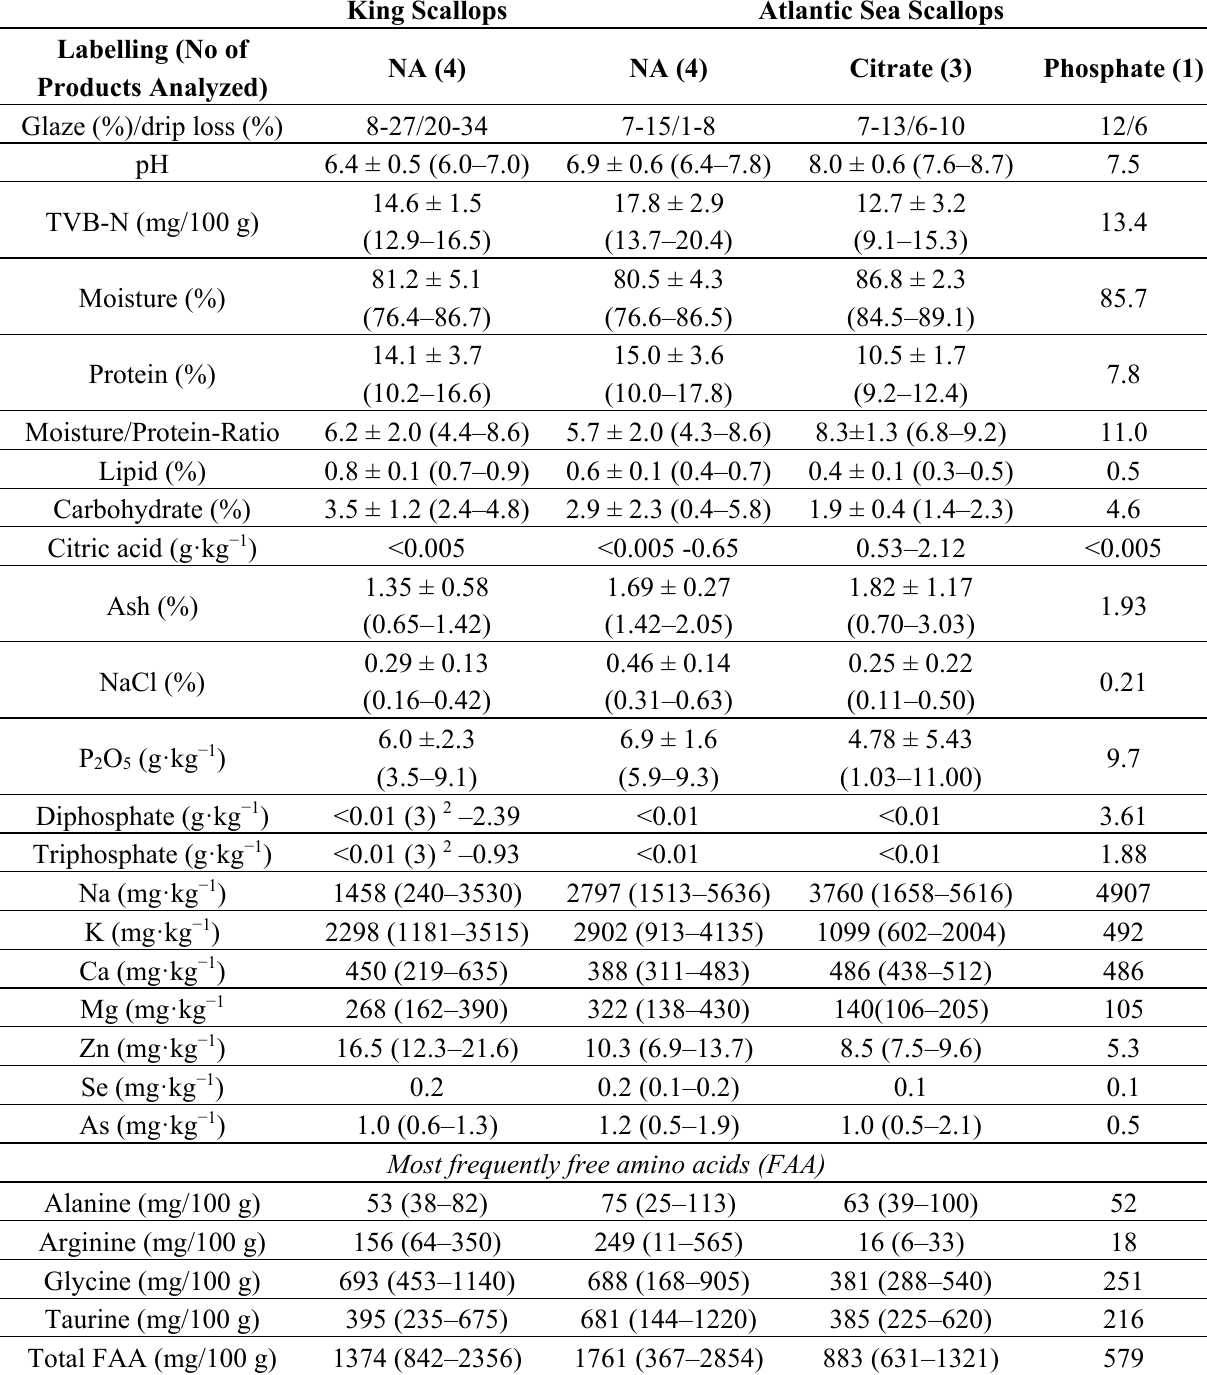
Table 3. Composition of frozen meat products of king scallops and Atlantic sea scallops with no labelled information on additives (NA), or an addition of citrate E331 or E330/331 or phosphate E451, respectively (arithmetic mean ± standard deviation; minimum-maximum amount) 1